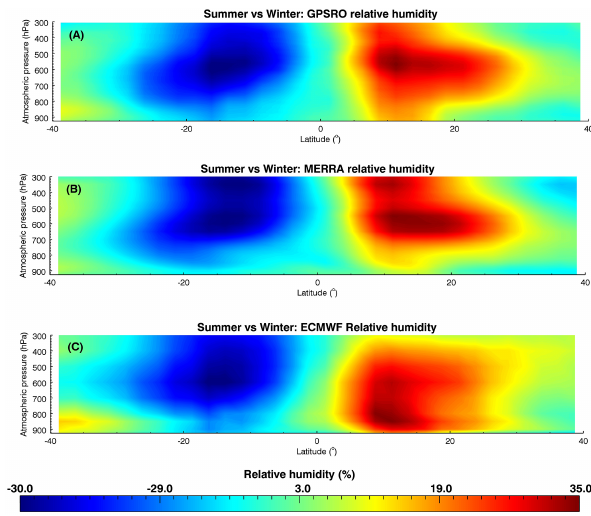
Figure 4. Pressure–latitude cross sections of seasonal variability (summer versus winter) of the relative humidity climatology aver- aged over the 2007–2009 period using (a) GPSRO observations and (b) MERRA and (c) ECMWF reanalyses.